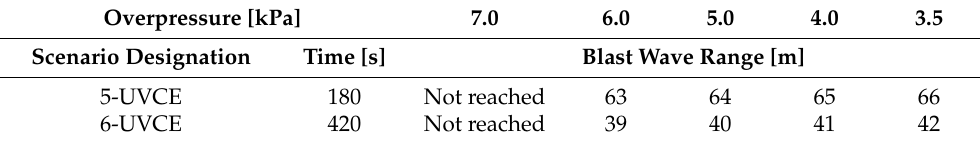
Table 7. Blast wave range.